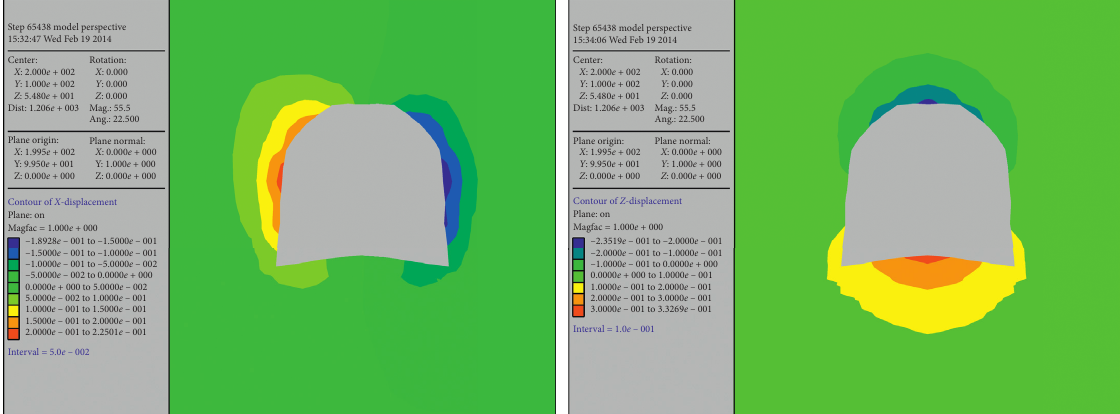
Figure 12: The nephograms of displacement (Scheme 2).